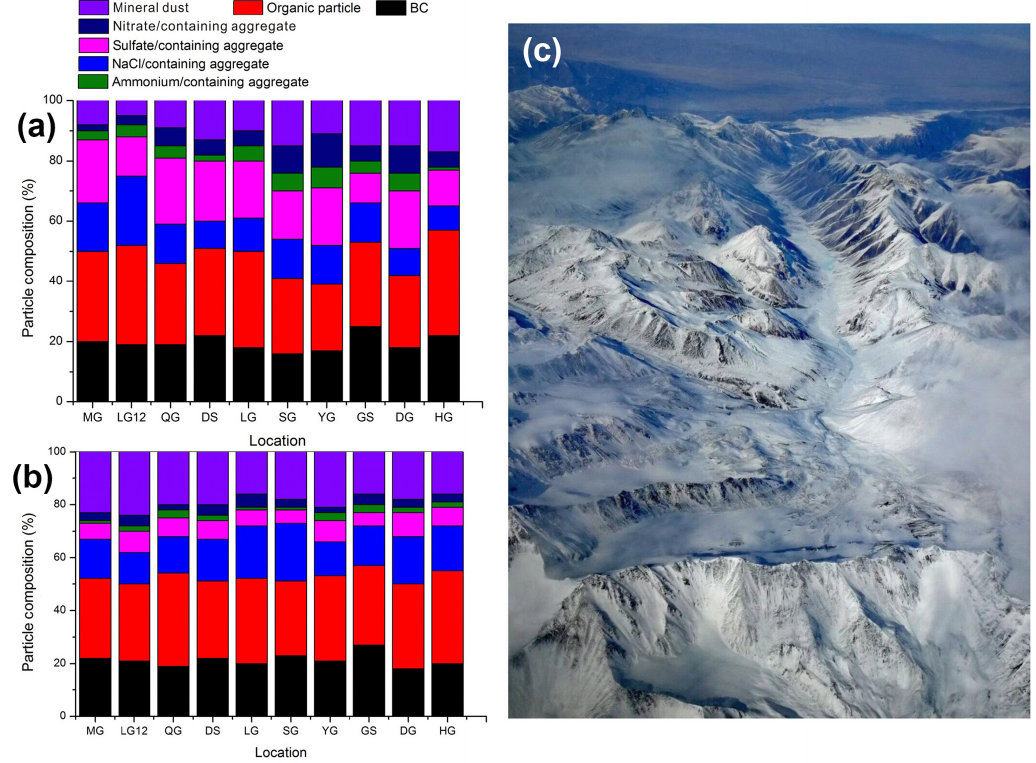
Figure 3. Comparison of individual particle compositions of light-absorbing impurities in the (a) atmosphere and (b) glacier–snowpack sur- face in the northeastern Tibetan Plateau, and (c) a photo of snowpack and glaciers in the Qilian Mountains taken from a flight in autumn 2017, showing a large distribution of snow cover and glaciers in the northern Tibetan Plateau